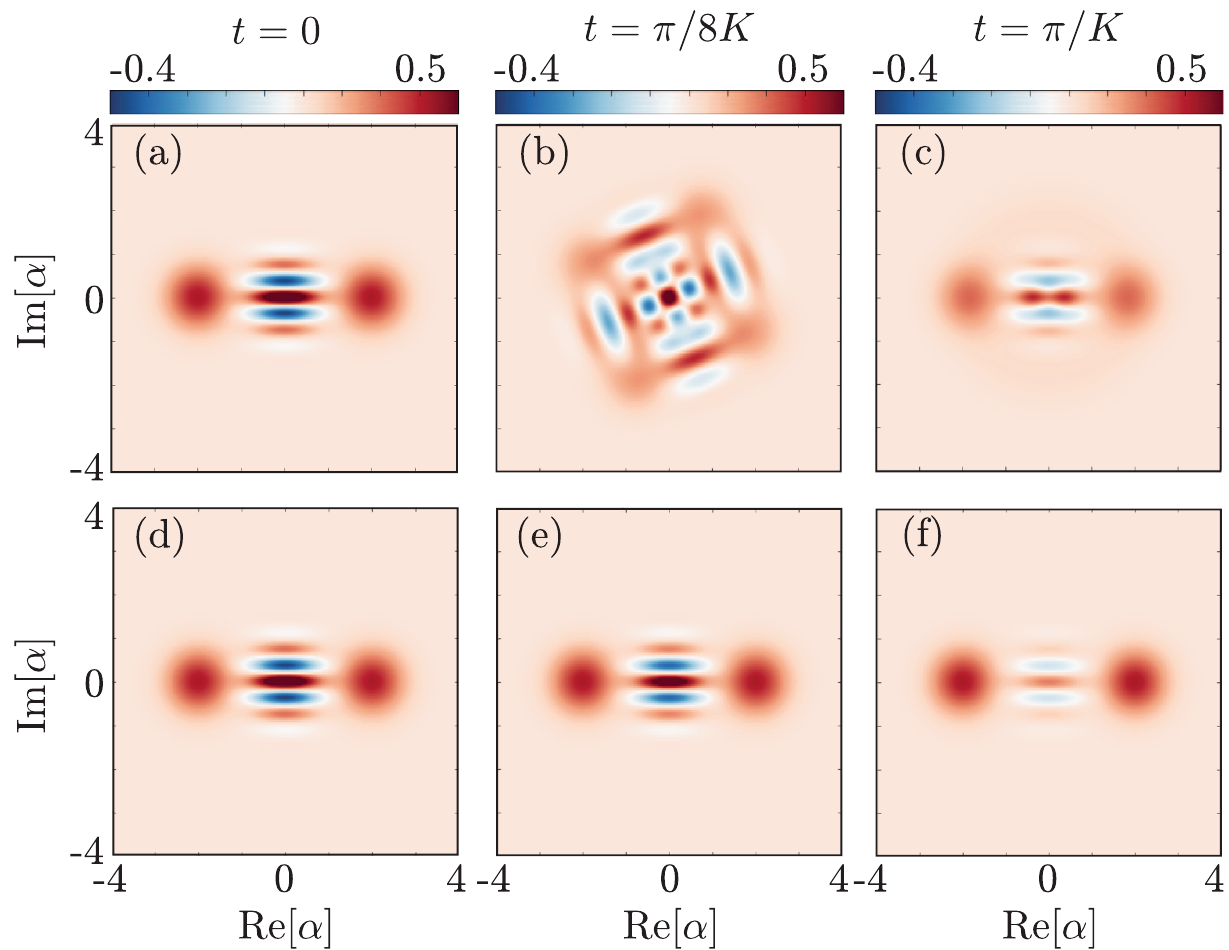
(cid:1) (cid:3) (cid:1) without a – c and with d – f two-photon driving. K / κ = 20 and E p ~4 2